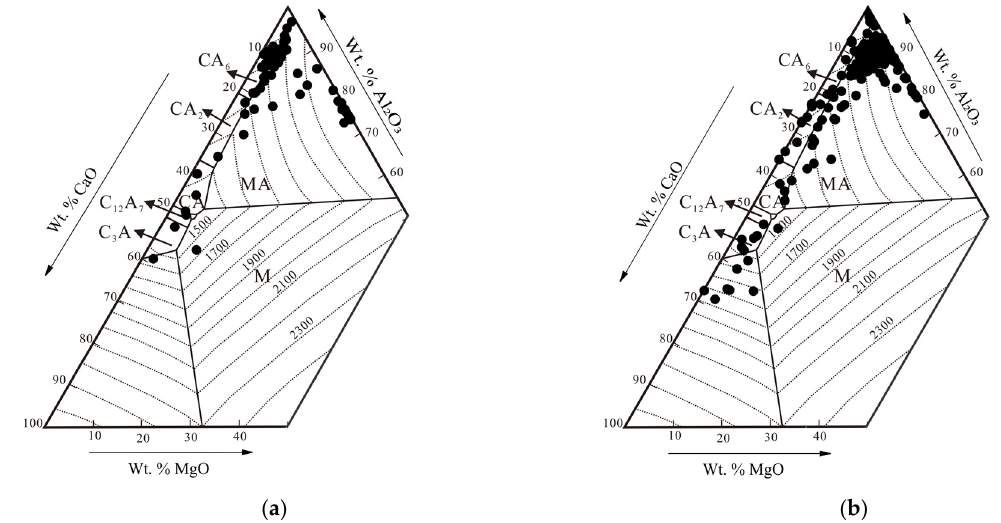
Figure 4. The composition distribution of Al 2 O 3 -MgO-CaO inclusions on the Al 2 O 3 -MgO-CaO phase diagram. ( a ) GS1 sample, ( b ) GS2 sample.